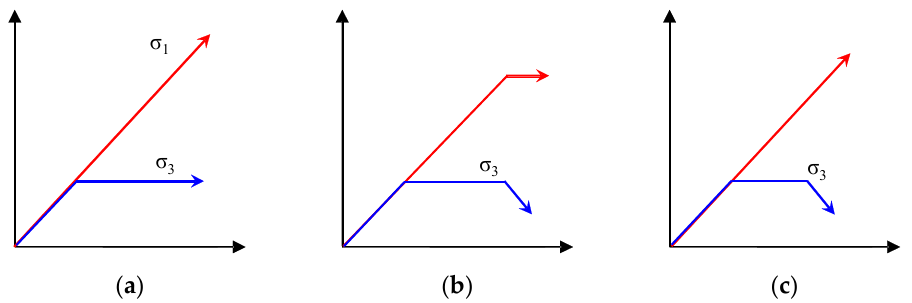
Figure 3. Schematic diagram of experimental loading path. ( a ) Test 1, ( b ) Test 2, ( c ) Test 3.